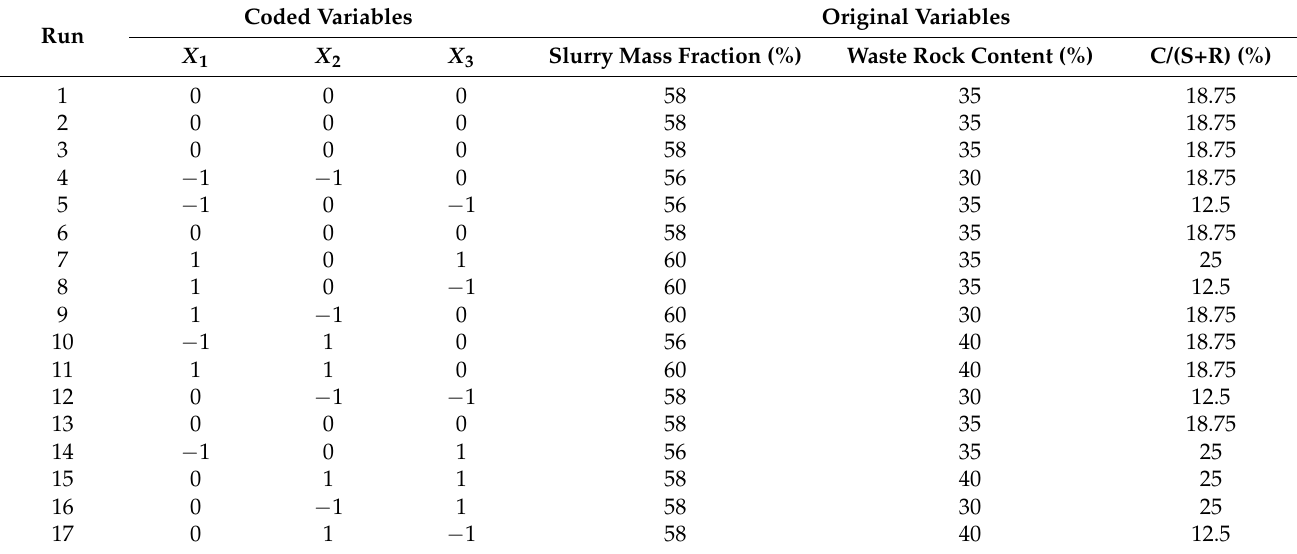
Table 4. Box–Behnken design scheme.